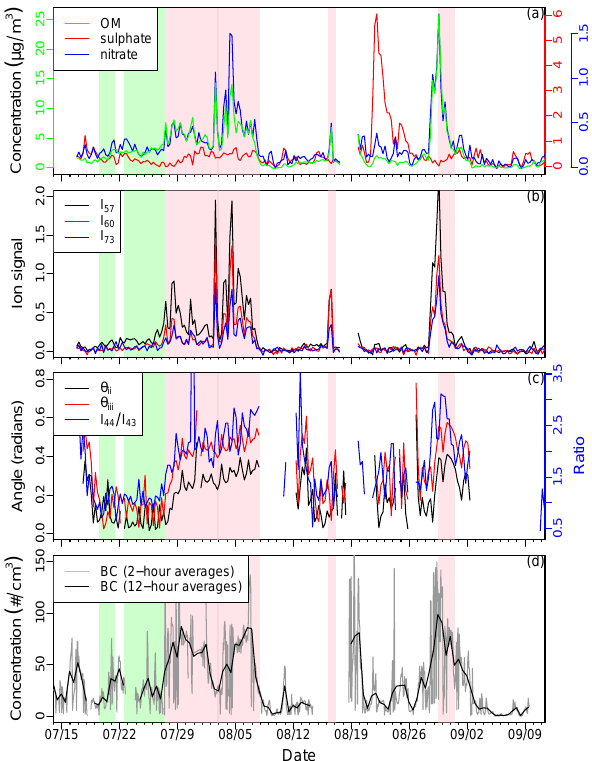
Fig. 7. Time series of (a) fire counts, (b) supermicron number con- centrations and mode of full number size distributions (c) potas- sium to sulphate or equivalent sulphate (all sulphur assumed to be sulphate) ratios measured by IC and XRF, and (d) non-soil K cal- culated from XRF measurements. Boxes for XRF measurements enclose concentrations measured during day and night when both samples were analyzed by XRF. Size distribution modes in (b) are from MSP Particle System (prior to 1 July) and TSI SMPS (after- wards). Non-soil K in (d) is calculated as K = R soil Al , where a value of R soil = 0 . 06 is used (Gilardoni et al., 2009). Panel shading colours indicate same information as Fig.